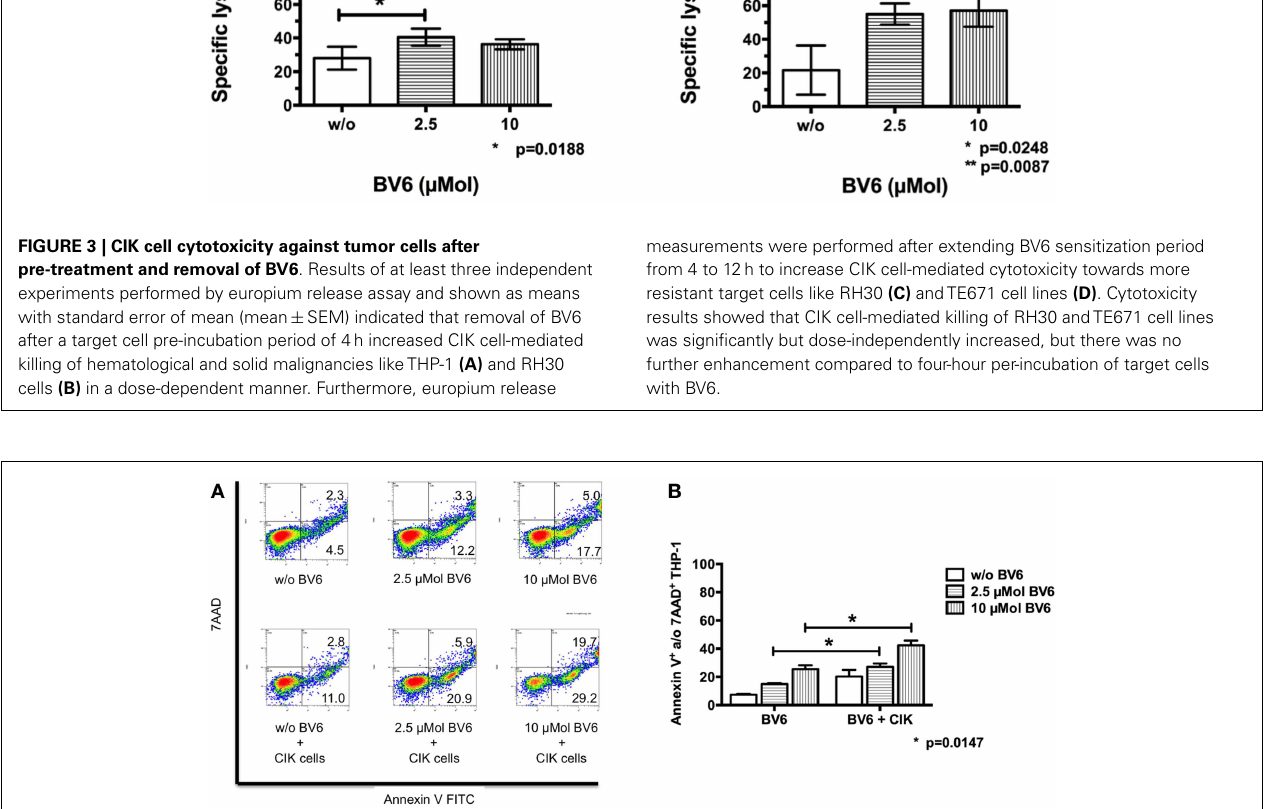
FIGURE 4 | CIK cell-mediated cytotoxicity after dose escalation of BV6 pre-treatment . Cytotoxic effects of both, increasing doses of BV6 and CIK cells were analyzed by flow cytometry. One representative example is shown (A) . Hereby,THP-1 cells were treated with 2.5 or 10 µ Mol BV6 for 4h and were incubated with CIK cells at an E:T ratio of 5:1 for another 3h.THP-1 and CIK cells were differentiated by forward scatter and CD33-expression.